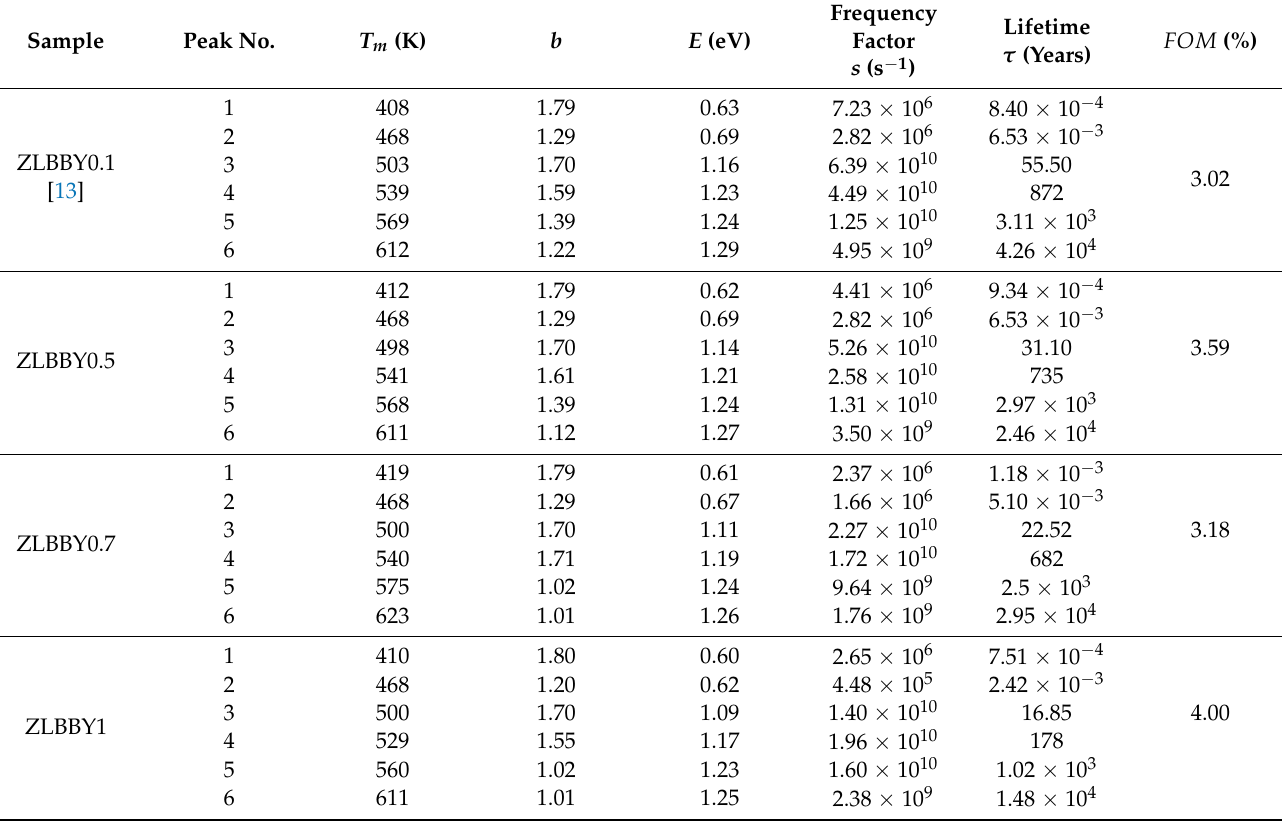
Table 1. Trap parameters of the ZLBBY glasses computed by the CGCD